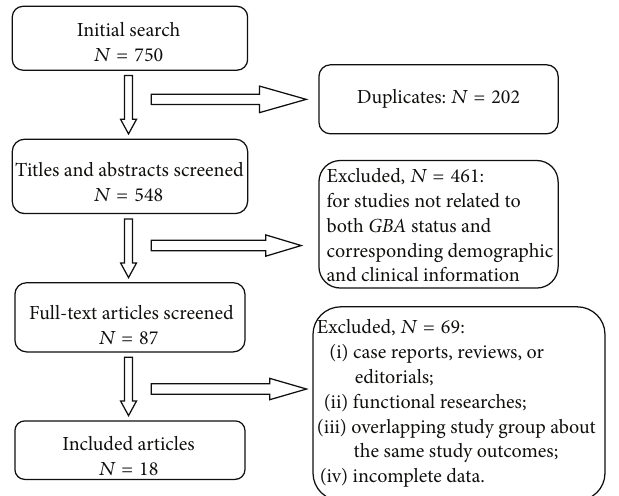
Figure 1: Flowchart of included publications.